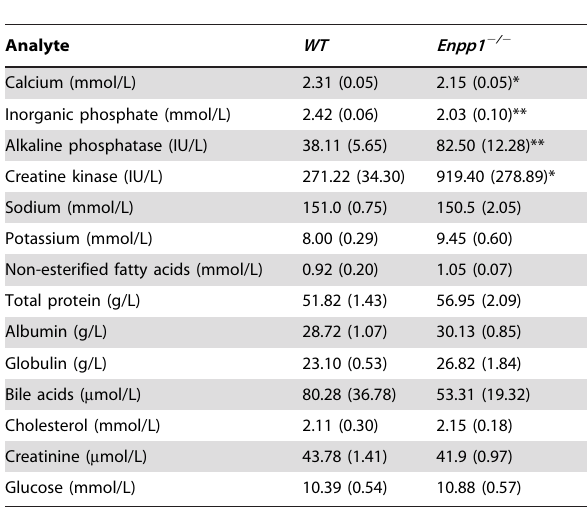
Table 4. Measurements taken of blood serum biochemistry of female 22 week old wild-type and Enpp1 2 / 2 mice.